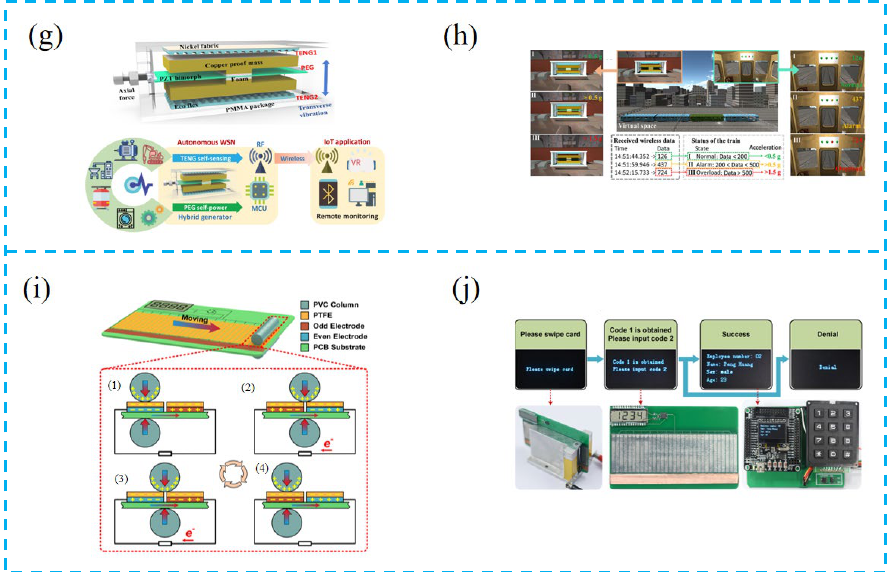
Figure 10. ( a ) Photographs of 140 commercial blue and green LEDs connected in series directly lightened by 2% Ca-BZT-based HNG without any rectification. ( b ) Charging curves of various ca- pacitors with the capacitances of 0.47, 2.2, 4.7, 22, and 47 μF, rectified voltage of 2% Ca-BZT-based HNG device. ( c ) Instantaneous activation of 70 LEDs and 180 LEDs under periodic hand compres- sion for device areas of 1 × 1 cm 2 and 3 × 3 cm 2 , respectively. ( d ) ( 1 ) The open-circuit voltage and ( 2 ) the short-circuit current under a repeatable hand compressive process for a device area of 1 × 1 cm 2